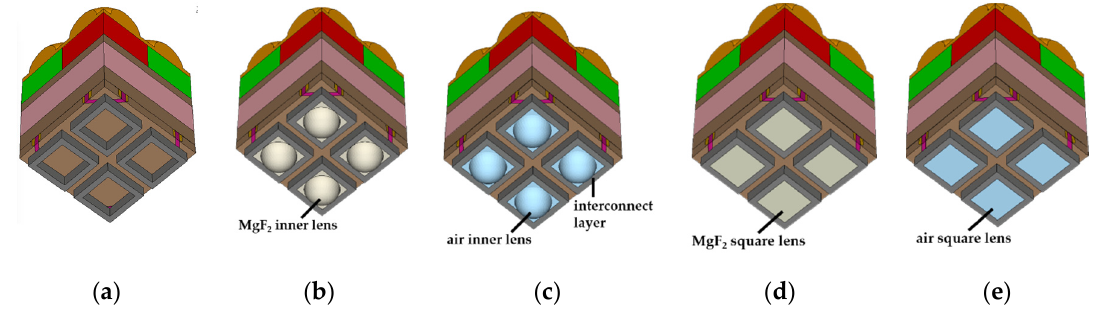
Figure 2. Simulated 3D pixel structures at the 1.0 µ m pixel depth: ( a ) Typical structure, ( b ) front-inner lens with MgF 2 , ( c ) front-inner lens with air, ( d ) square front-inner lens with MgF 2 , and ( e ) square front-inner lens with air.